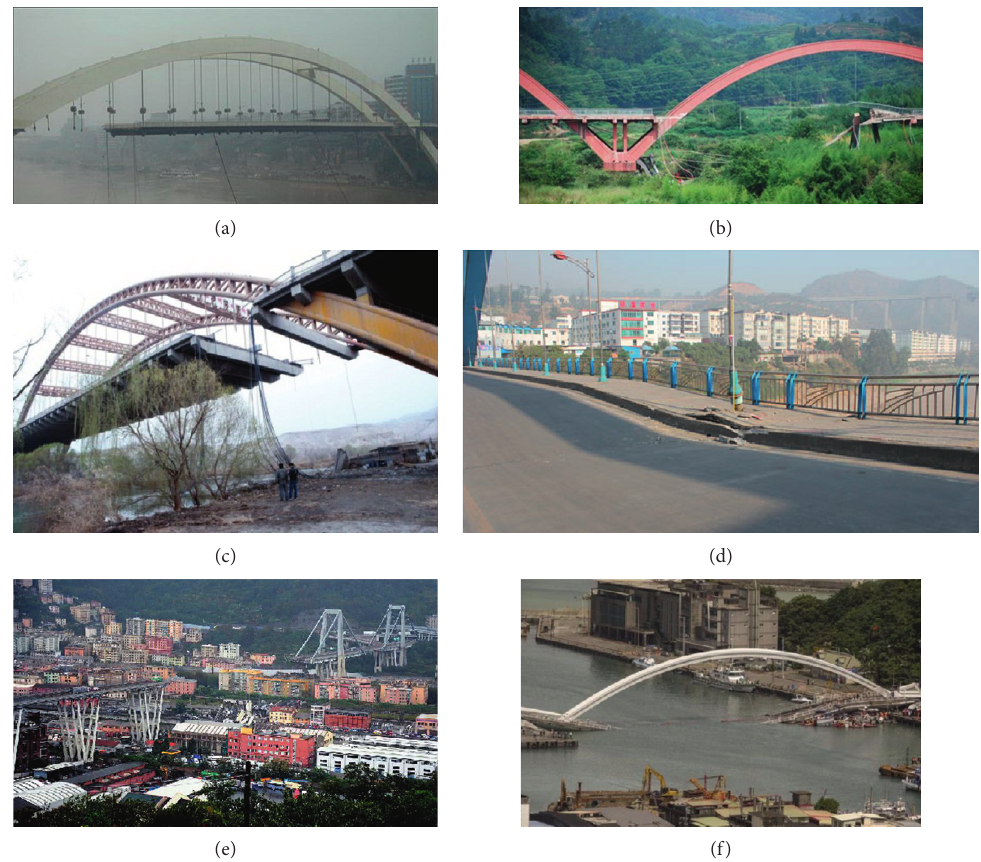
Figure 1: Cable breaking cases of cable bridges [1]: (a) Yibin little south gate bridge; (b) Peacock river bridge, Xinjiang; (c) Wuyishan mansion bridge, Fujian; (d) Sichuan Jinsha River Luoguo bridge; (e) Ponte Morandi bridge, Italy; (f) South Australia sea crossing bridge in Taiwan